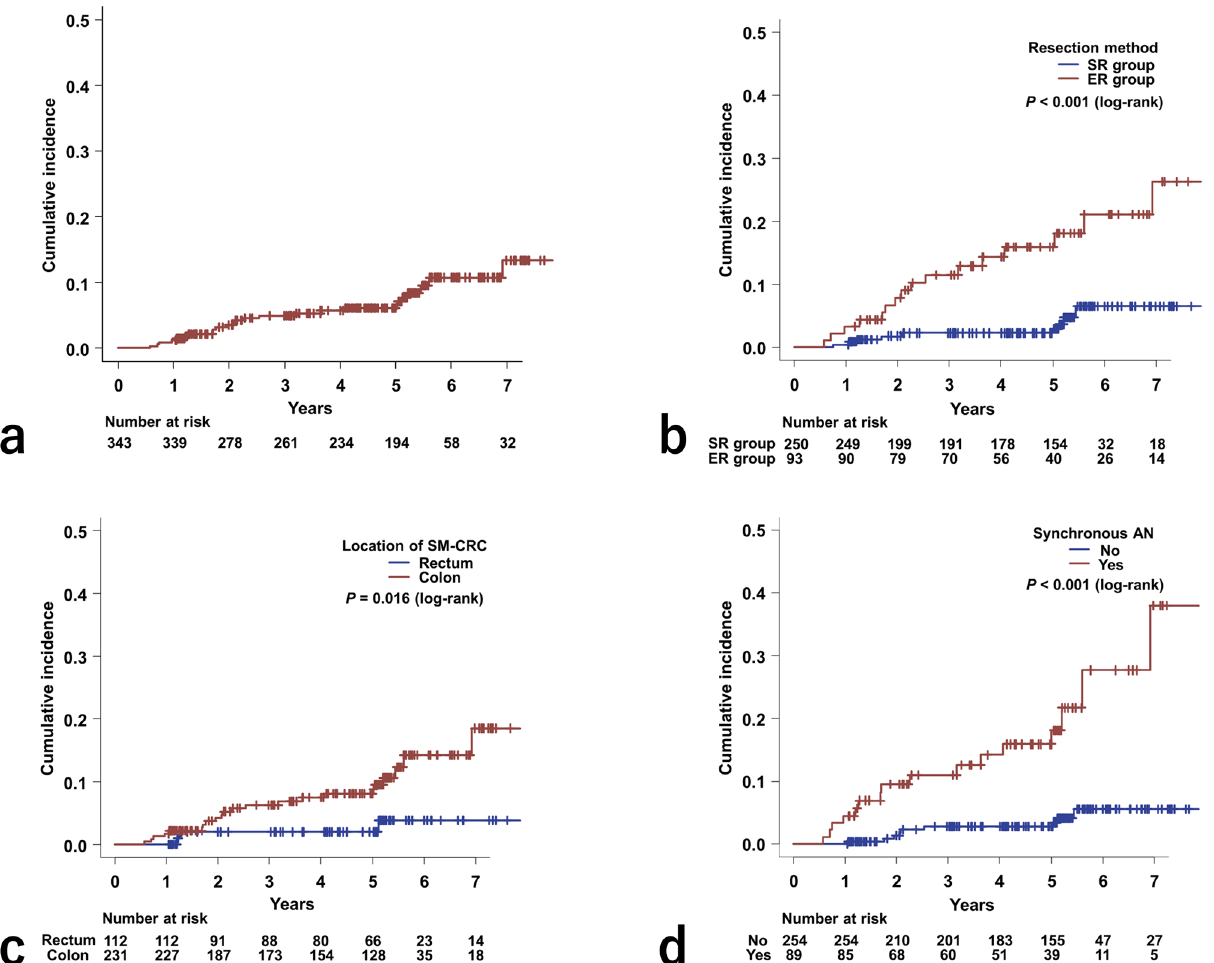
Figure 2. Cumulative incidence of metachronous advanced neoplasia after resection of submucosal invasive colorectal cancer ( a ) in the entire study group, ( b ) according to the resection method, ( c ) according to the location of submucosal invasive colorectal cancer, and ( d ) according to the presence of synchronous advanced neoplasia. ER endoscopic resection, SR surgical resection, SM-CRC submucosal invasive colorectal cancer, AN advanced